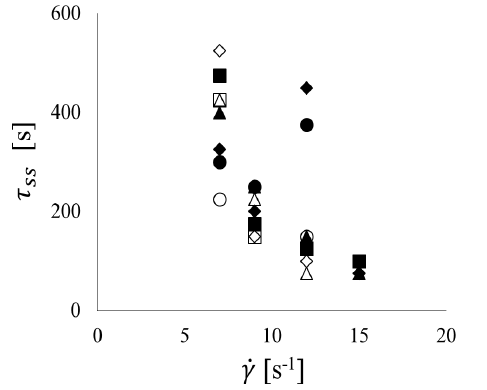
Figure 7: Timescales to reach steady state τ ss as a function of ap- plied shear rate for the interface position (squares), high shear rate (circles), low shear rate (triangles), and true shear rate (diamonds). Protocol 1 (no pre-shear) and protocol 2 (with pre-shear) appear with filled black and open black symbols